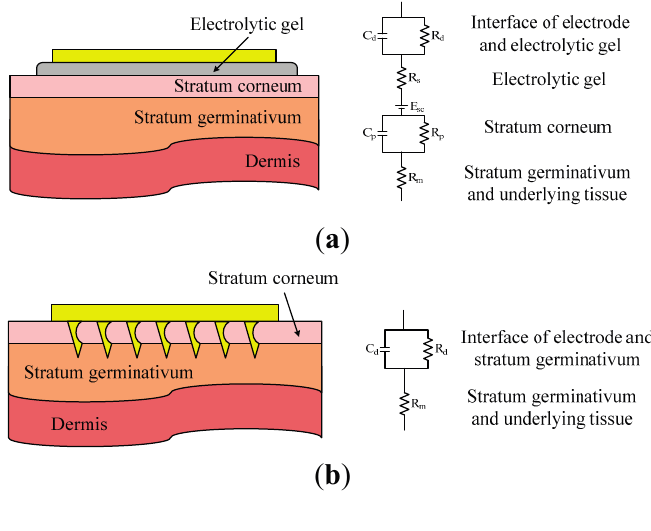
Figure 3. Cross-sectional schematic and simpli fi ed electrical model of ( a ) conventional wet electrodes and ( b ) barbed microtip-based dry